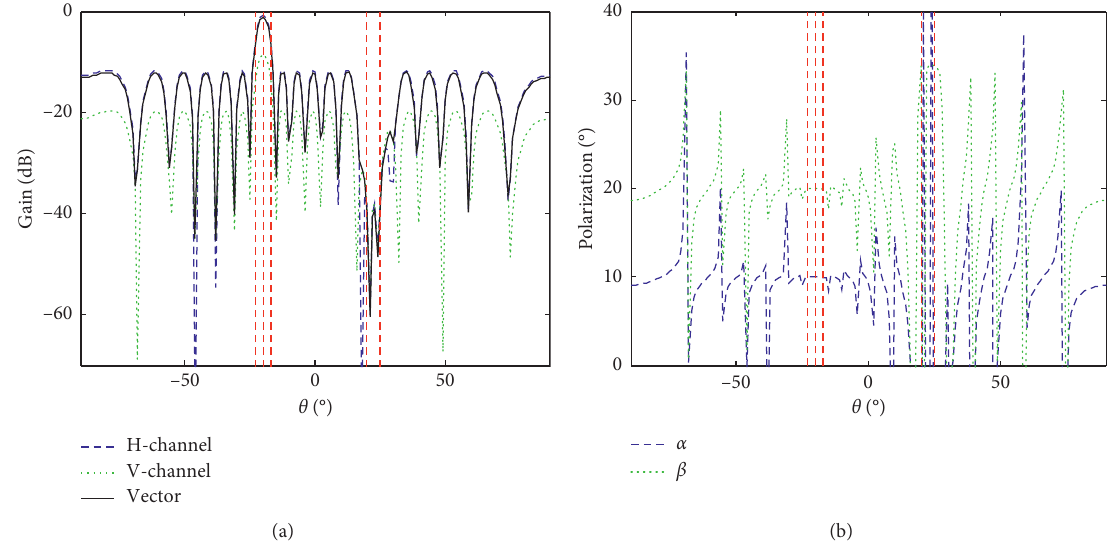
Figure 5: Second method of polarized beampattern in [6]. (a) Beampattern. (b) Polarization.